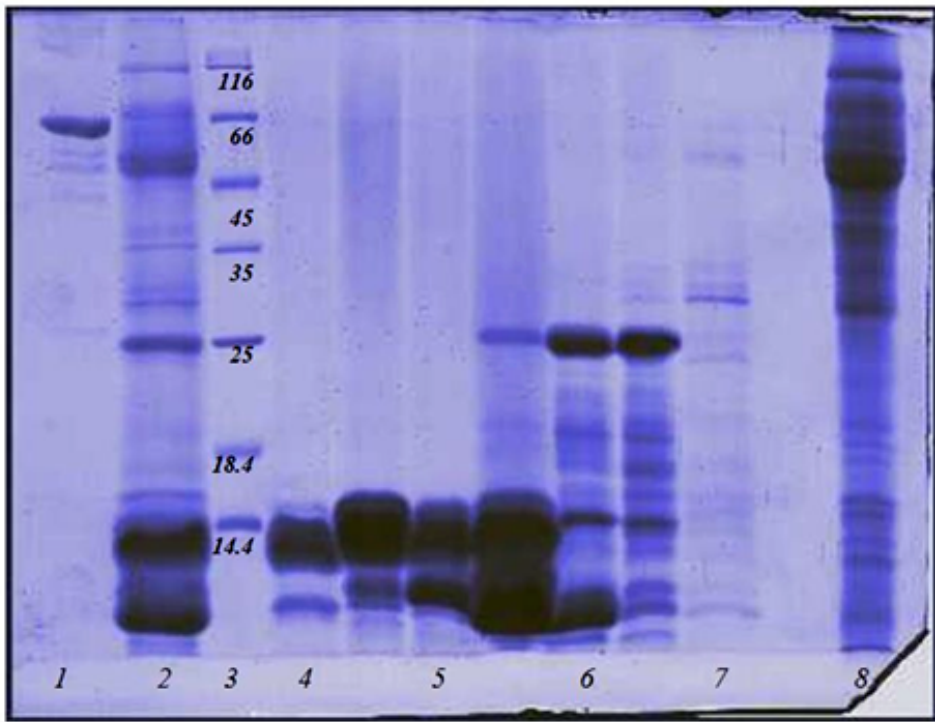
Figure 2. SDS-PAGE analysis of crude Naja oxiana venom and chromatographic fractions. Lane 1: albumin; lane 2: crude venom; lane 3: protein markers; lane 4: fraction F4; lane 5: fraction F3; lane 6: fraction F2; lane 7: fraction F5; lane 8: fraction